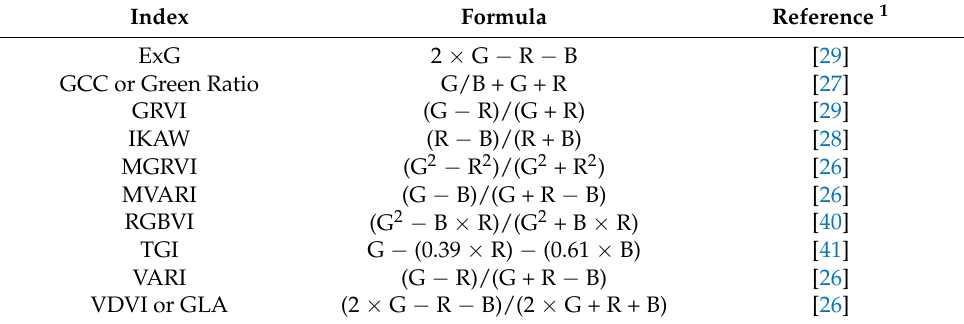
Table 1. Vegetation Indices computed for sUAS biomass